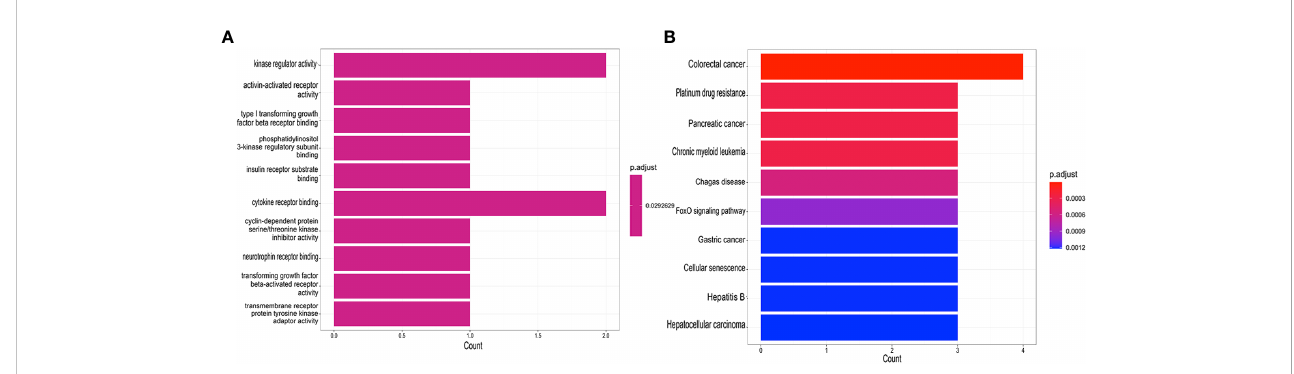
FIGURE 4 Functional enrichment analyses of the shared genes. (A) GO analysis of the shared genes. (B) KEGG pathway enrichment analysis of the shared genes.